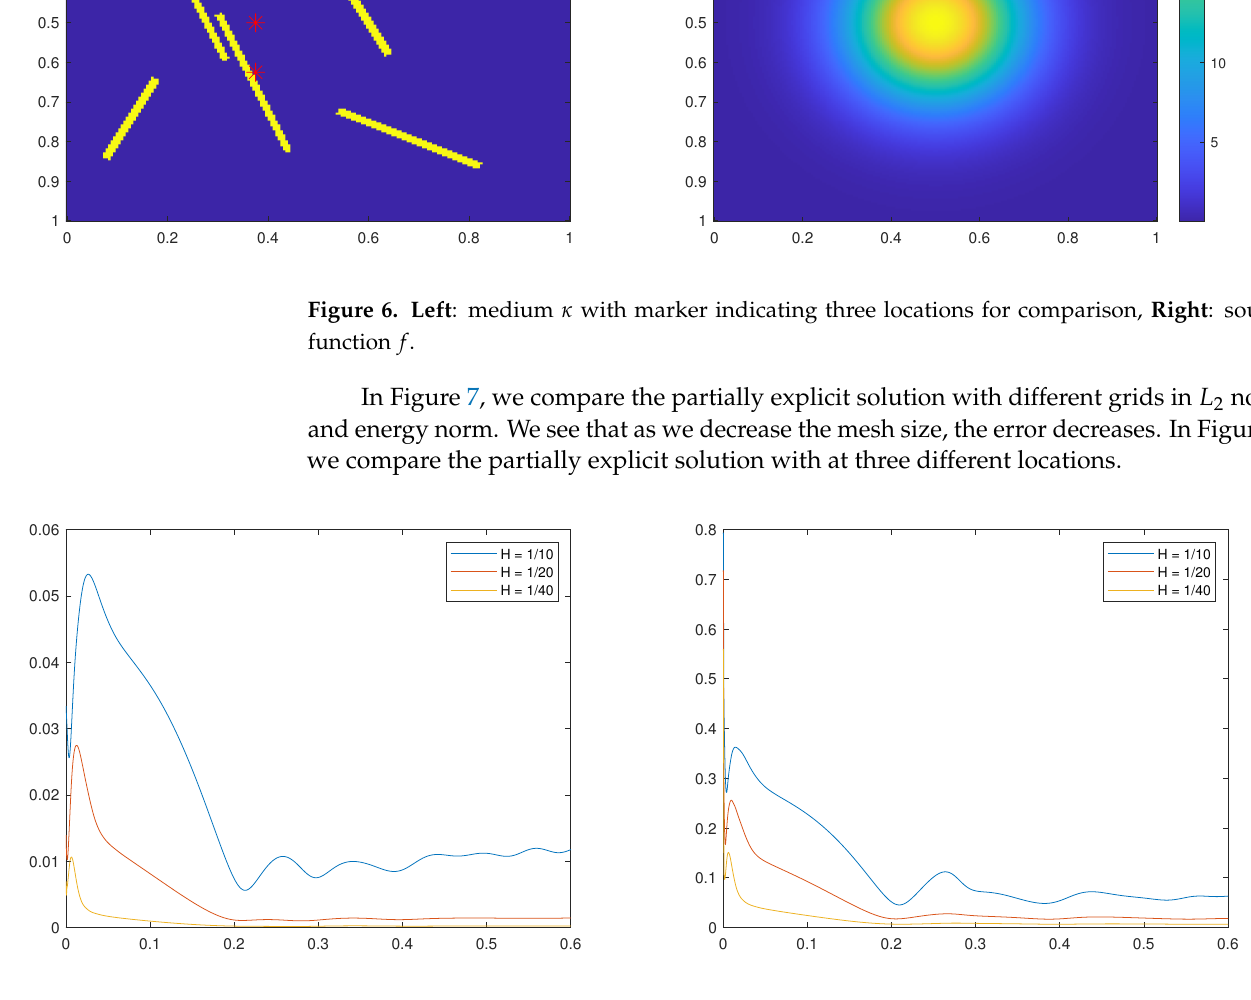
Figure 7. α = 0.5, dt = 5 × 10 − 5 . Left : L 2 error. Right : Energy